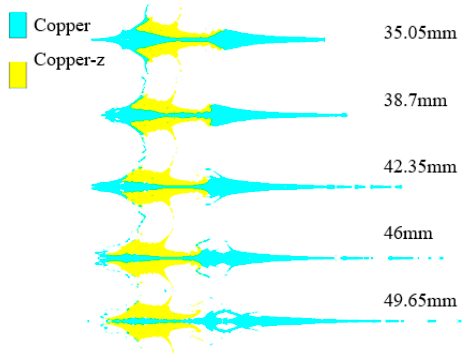
Figure 13. Jets formed by SCS liner with different inner surface bus radius.